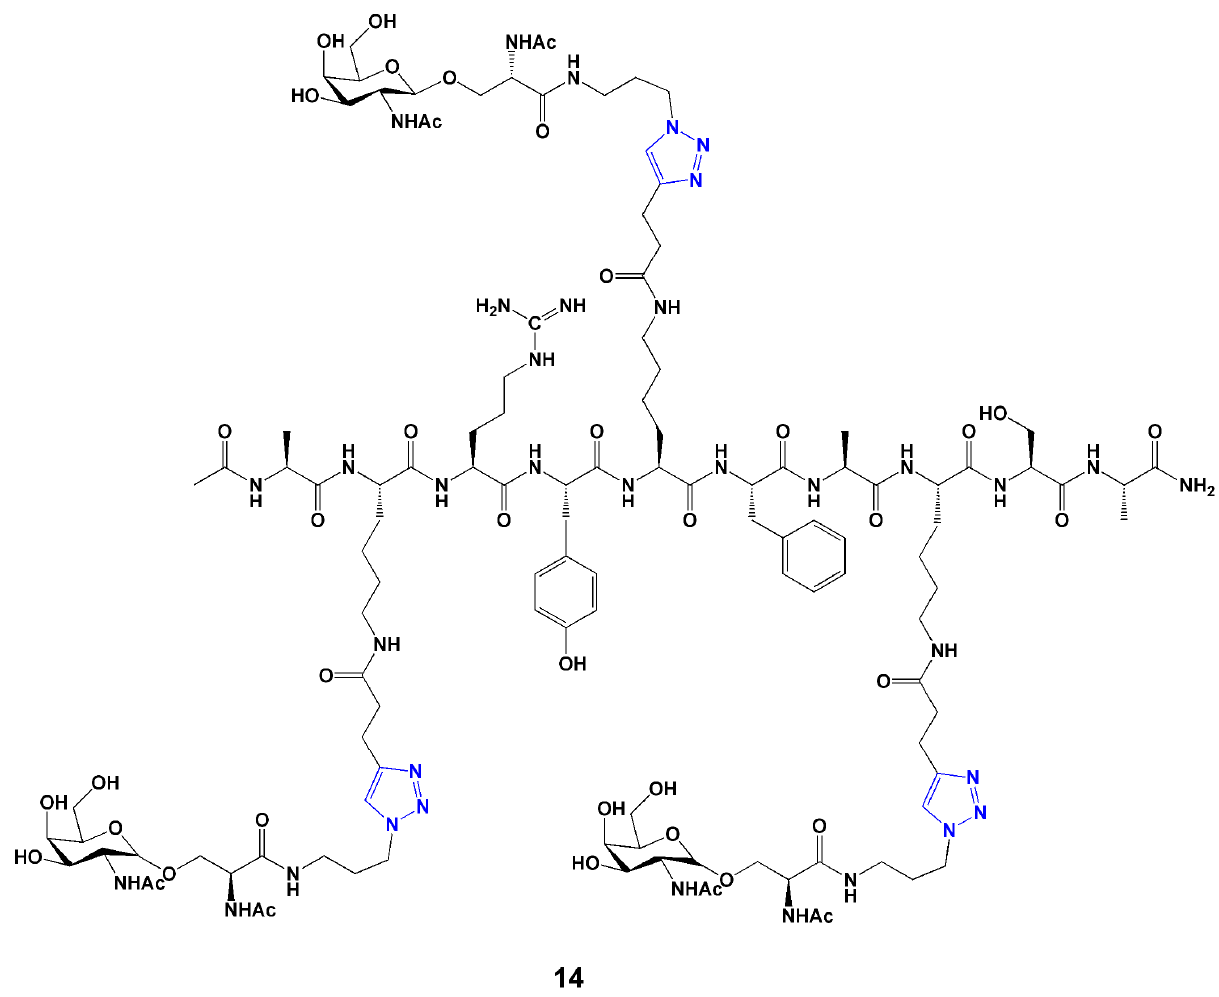
Figure 6. Structure of an anti-cancer carbohydrate-peptide vaccine candidate